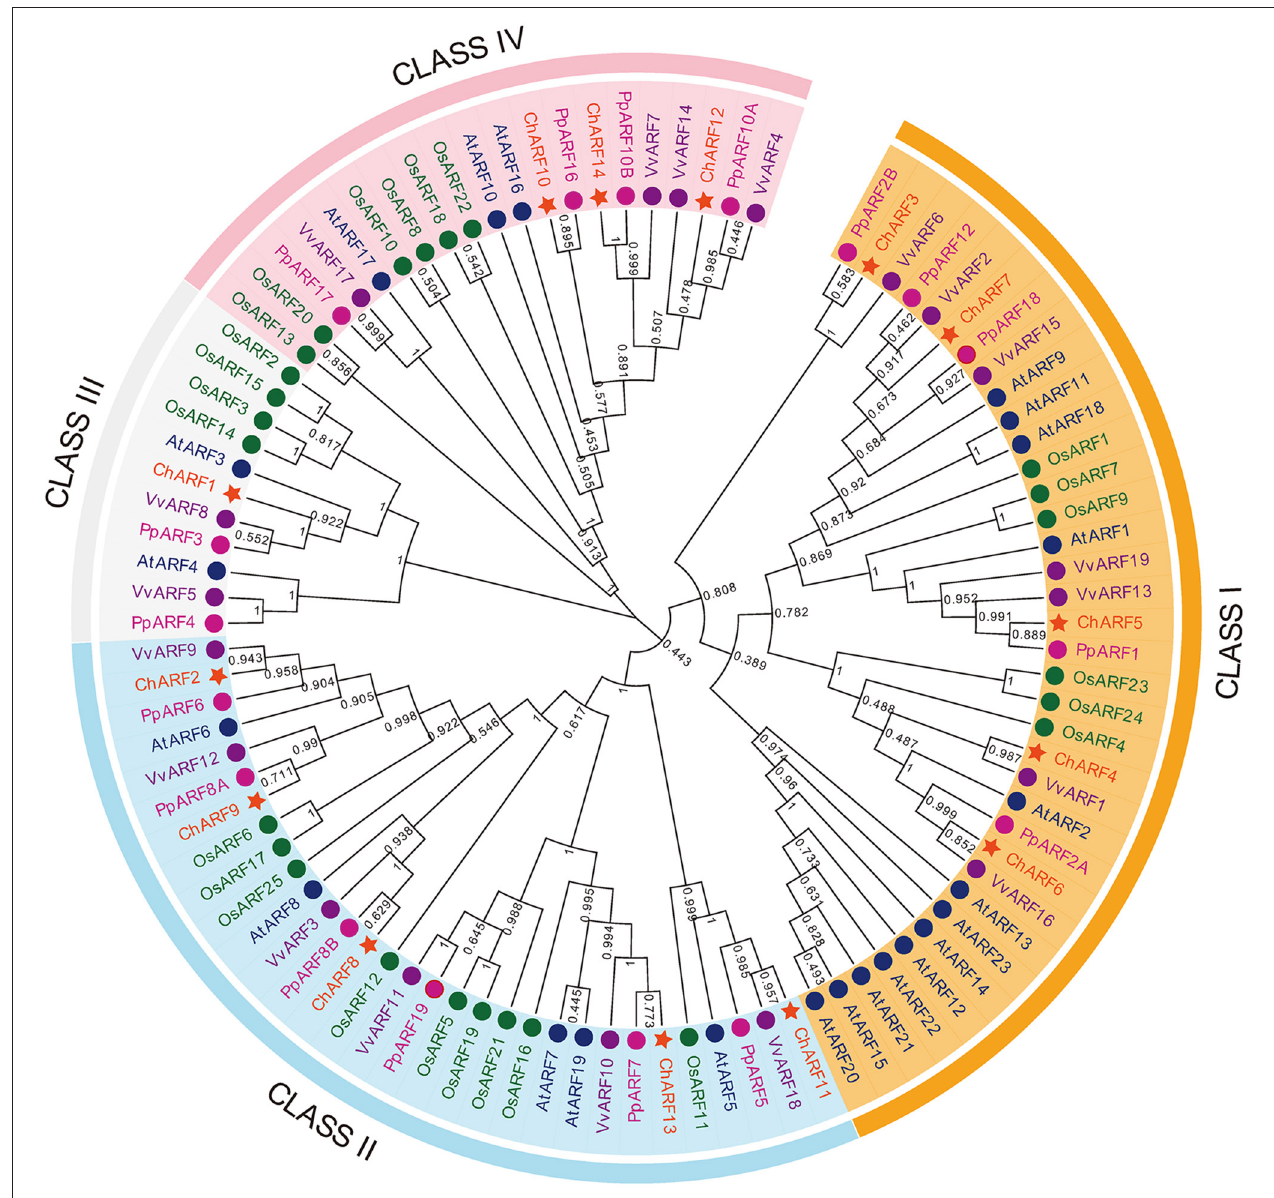
FIGURE 1 | Phylogenetic analysis of Arabidopsis , grape, peach, rice, and hazel ARF proteins. Amino acid sequences of full-length predicted ARF proteins were aligned using MUSCLE program. Phylogenetic tree was generated using MEGA v7.0 program via neighbor-joining method with 1,000 Bootstrap